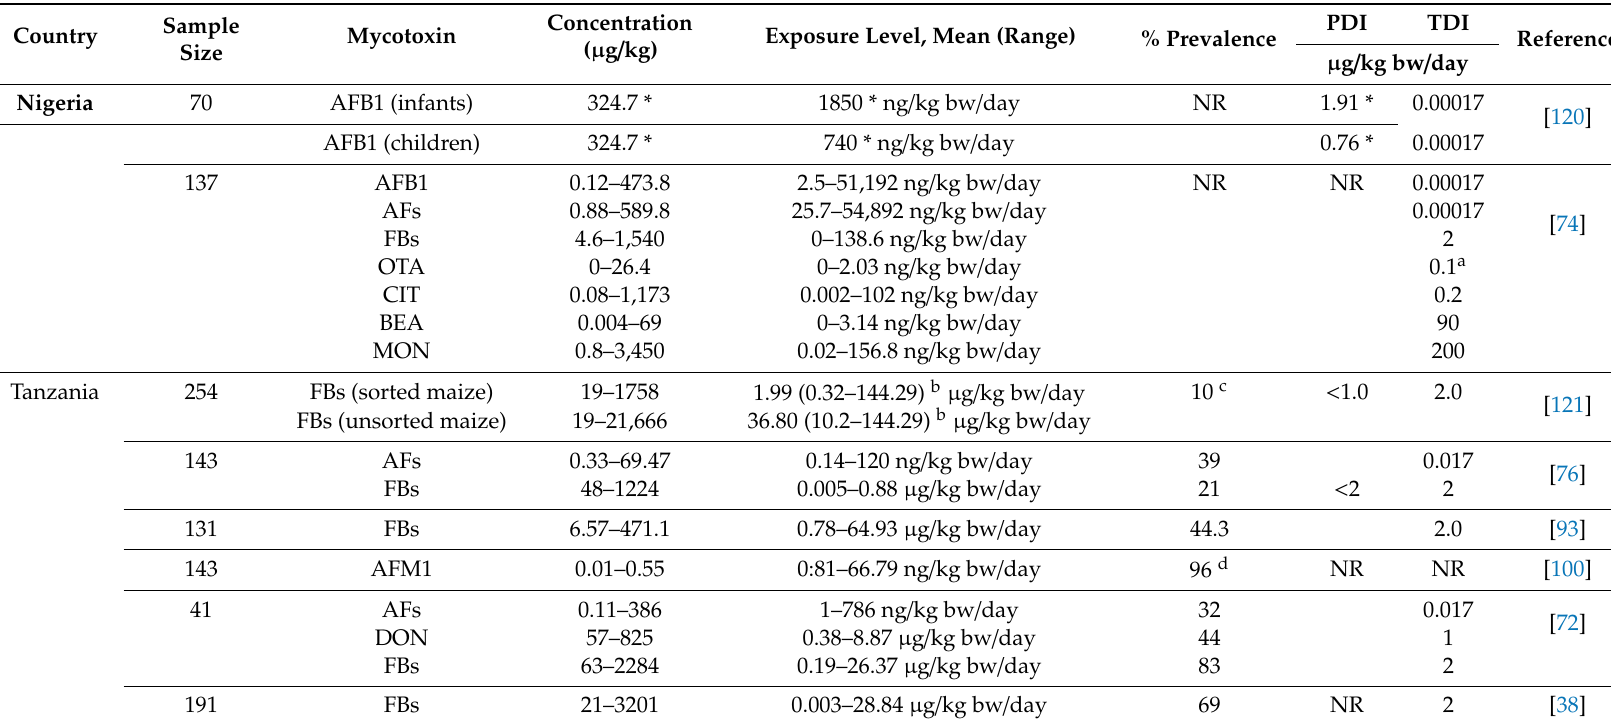
Table 3. Summary of mycotoxin exposure studies on infants and young children in sub-Saharan Africa using occurrence and consumption data. Country